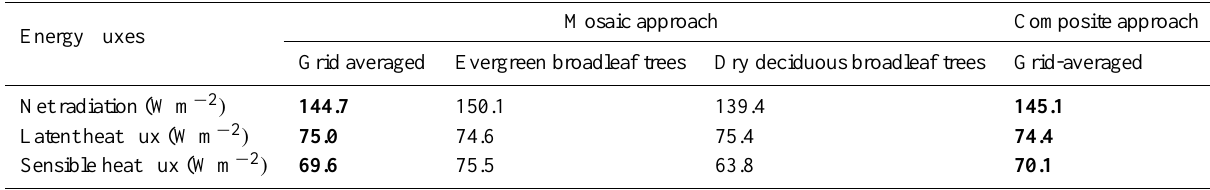
Table 3. Average annual values of primary energy fluxes at the Africa location when using the composite and mosaic approaches.